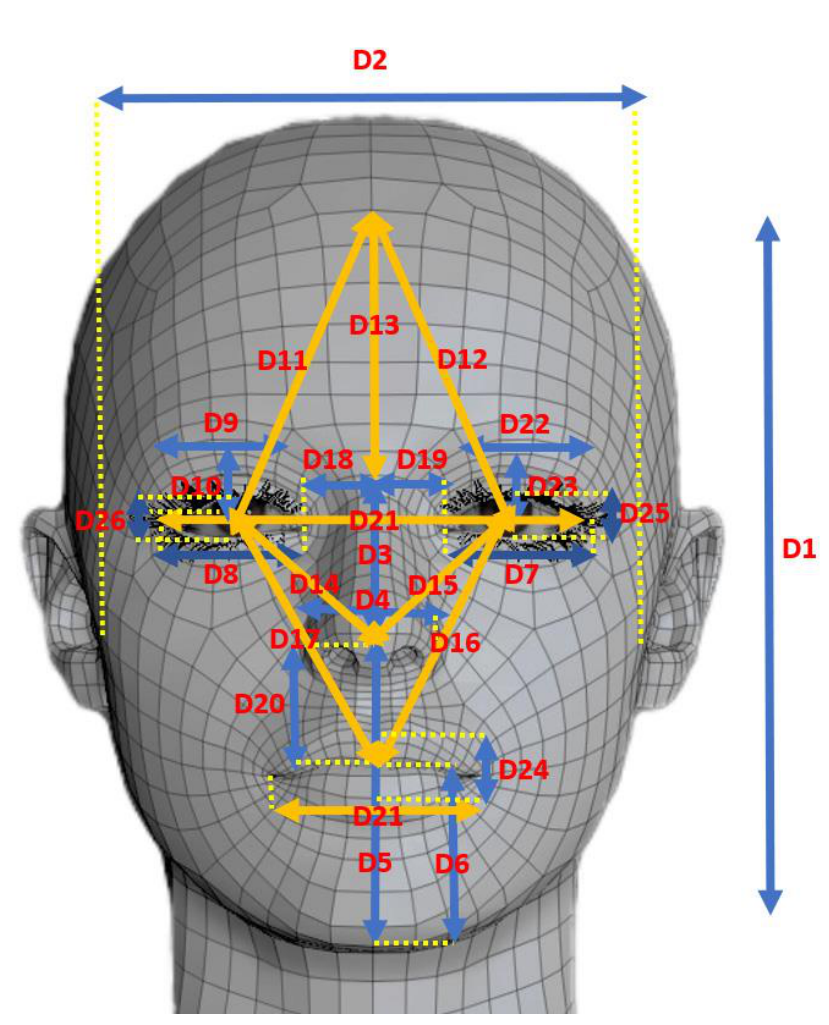
Figure 6. Facial geometrics features used in Table 3.